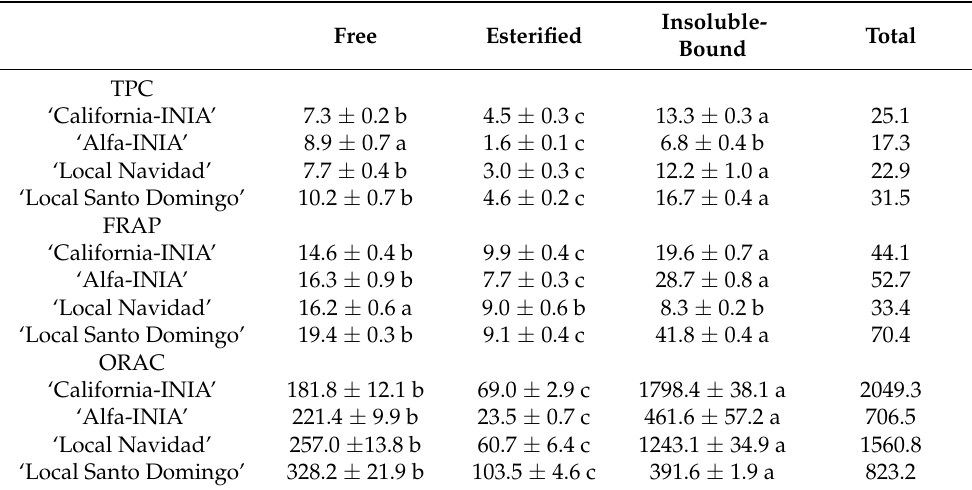
Table 2. The TPC (mg GAE/100 g), FRAP ( µ mol TE/100 g) and ORAC ( µ mol TE/100 g) of soluble (free and esterified) and insoluble-bound compounds in